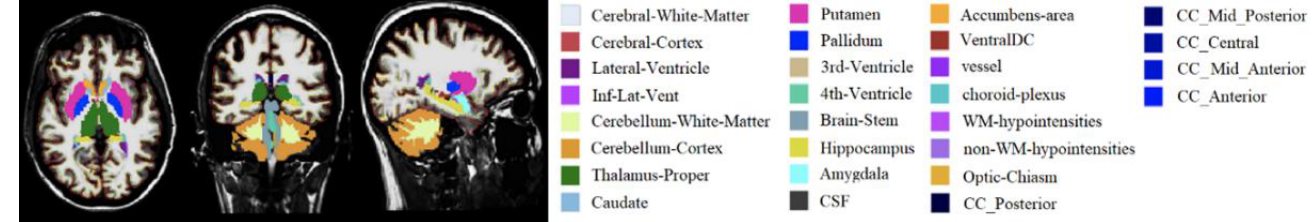
Figure 1. Brain segmentation provided by FreeSurfer software.